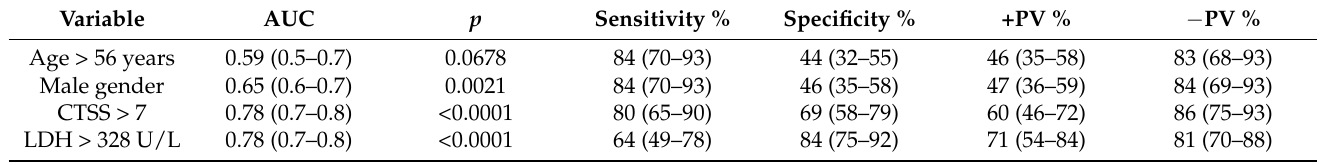
Table 3. Performance of different variables in the prediction of respiratory support.